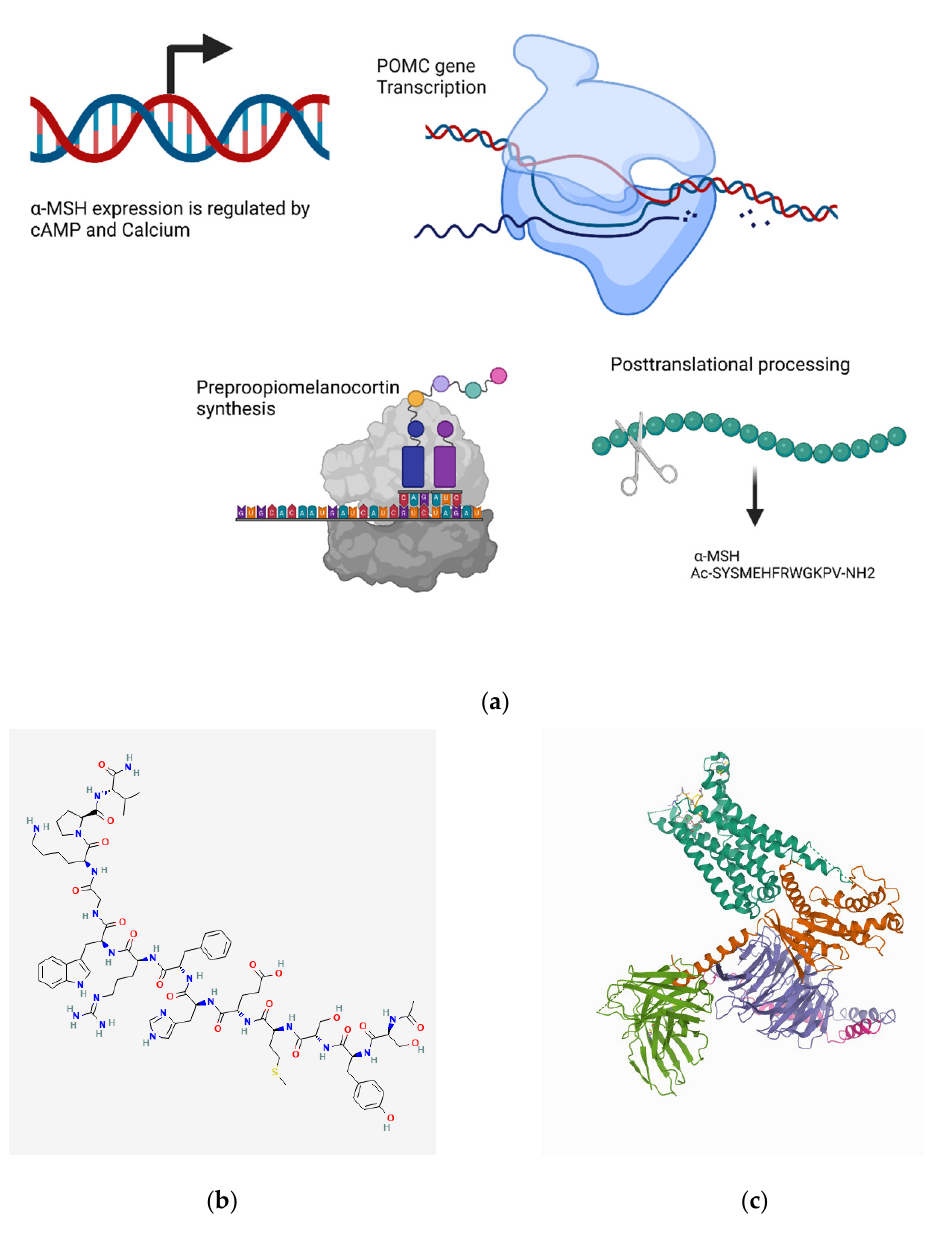
Figure 9. Neuropeptide α -MSH and MC4R: ( a ) transcription and synthesis of α -MSH (created with BioRender.com accessed on 22 October 2021); ( b ) 2D structure image of α -MSH (https://pubchem.ncbi.nlm.nih.gov/compound/44273719#section=2D-Structure, accessed on 22 October 2021); ( c ) melanocortin receptor 4 (MC4R) Gs protein complex. Image from the RCSB PDB (rcsb.org) of PDB ID 7AUE [504].